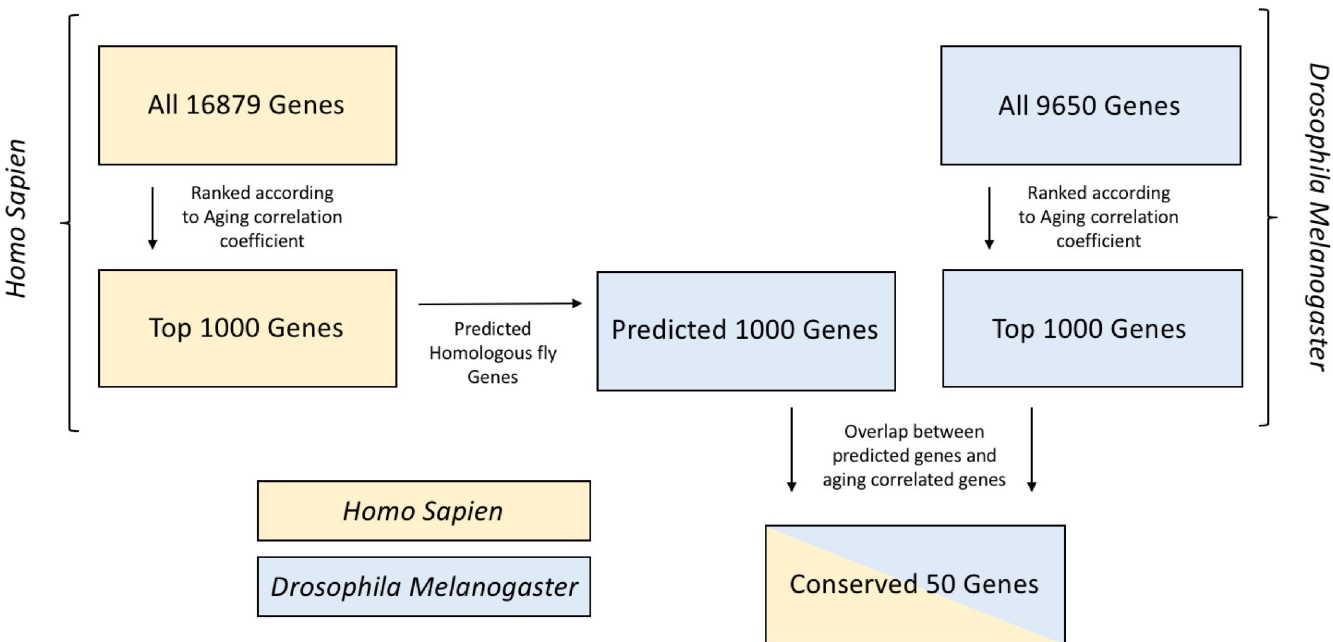
Fig 1. Workflow of biological age prediction using XGBoost across species. Depicting selection of genes for both aging involvement and conservation between Human and Drosophila .